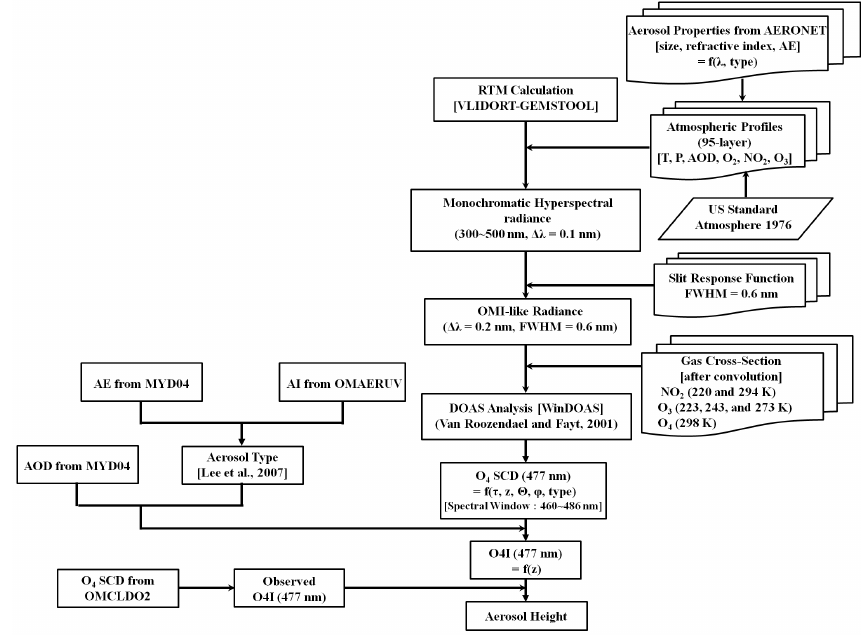
Figure 12. Flowchart of the retrieval algorithm for AEH from OMI